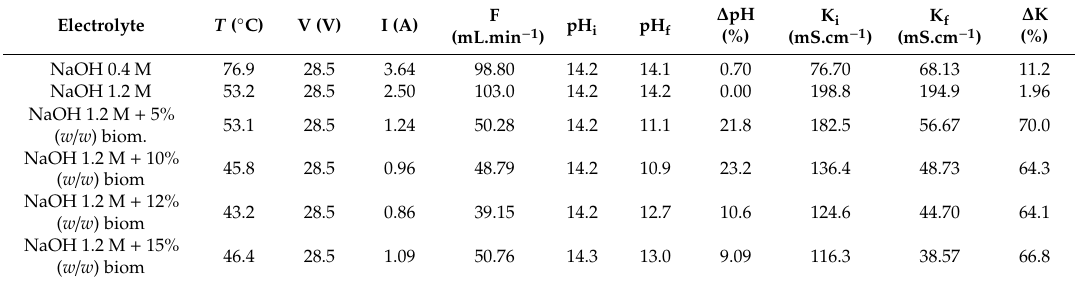
Table 3. Experimental results achieved regarding the experiences performed in the